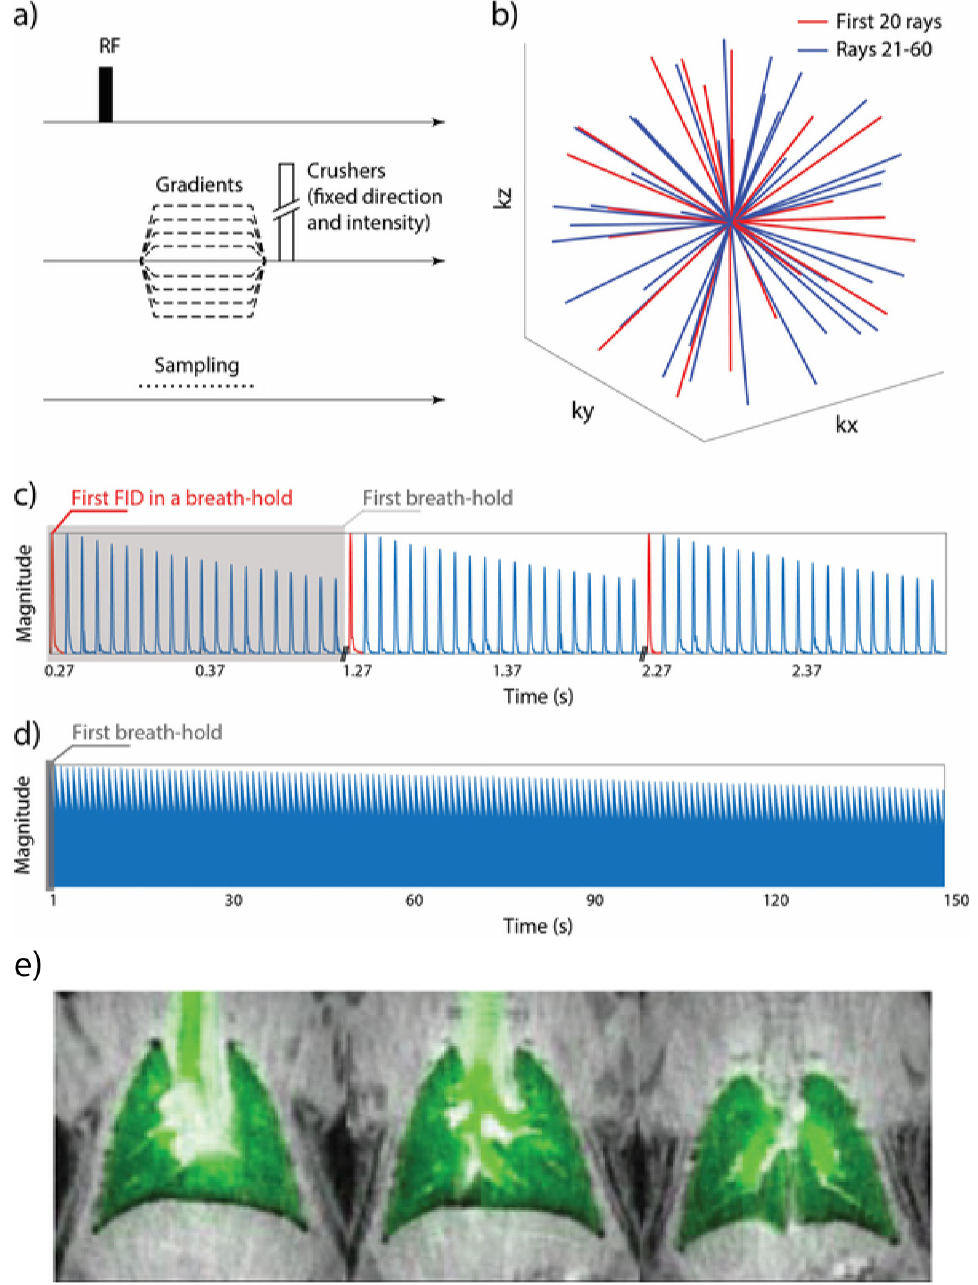
Figure 36. ( a ) Schematic of the UTE3D imaging sequence. ( b ) 60 representative radial rays, acquired in randomized order, to sample k-space uniformly over time (illustrated by the first 20 rays being shown in red). ( c ) Raw HXe gas-phase FIDs from the first three breath-holds of a rat imaging study. Within each breath-hold, 20 FIDS are acquired, with the amplitude of each subsequent FID decreasing due to RF-induced loss of magnetization. However, this is replenished by continued ventilation, and